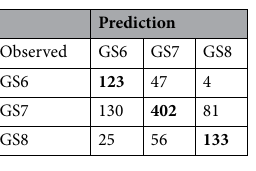
Table 1. RS-GBR-NMF-sparseLDA classification of Gleason score (test data).